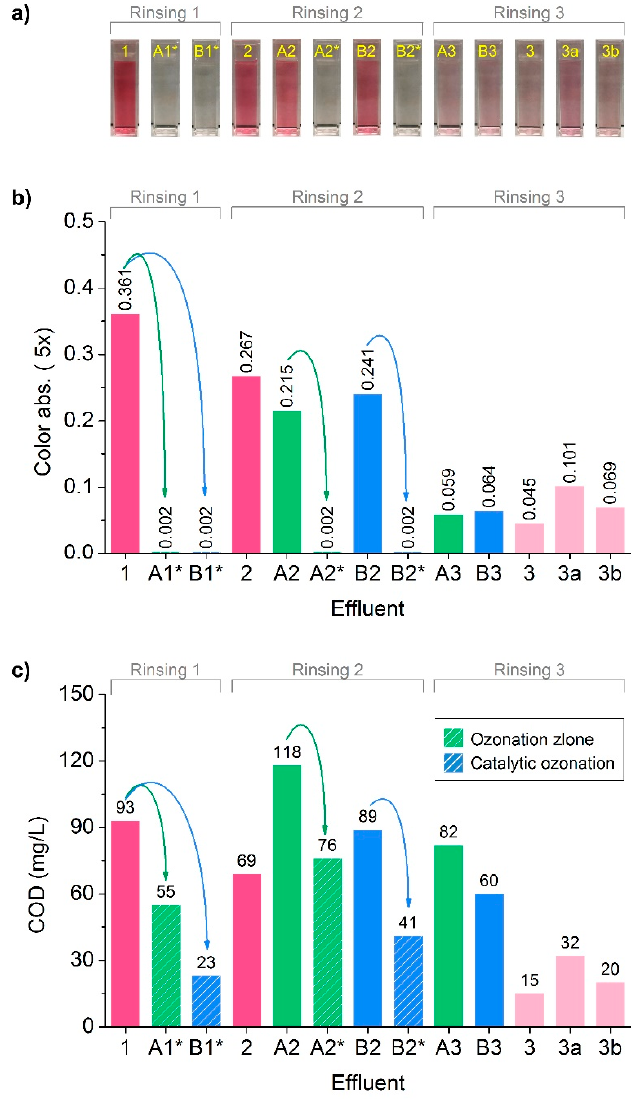
Figure 12. Selected effluents ( a ) and their color ( b ) and COD ( c ) evolution.